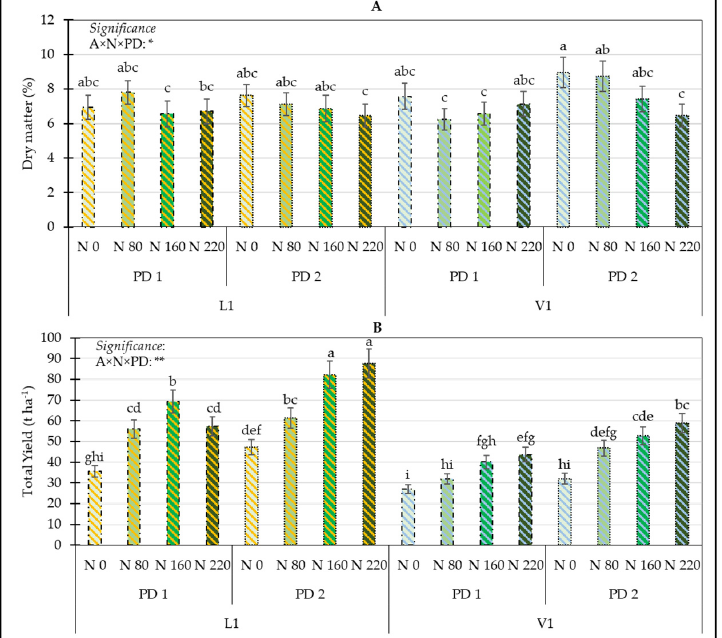
Figure 5. Influence of the interaction A × N × PD on dry matter ( A ) and total yield ( B ). Means with the same letter are not significantly different at p ≤ 0.05 according to Tukey’s test. Bars represent the standard error. ** = significant at p ≤ 0.01; * = significant at p ≤ 0.05; A = Accession; N = nitrogen; PD = Planting Date; L1 = Landrace (Bianca Calda di Comiso); V1 = Commercial Variety (Bianca di Mag- gio); N 0 = No-Nitrogen Fertilization; N 80 = fertilization with 80 kg N ha − 1 ; N 160 = fertilization with 160 kg N ha − 1 ; N 220 = fertilization with 220 kg N ha − 1 ; PD 1 = Early Planting Date; PD 2 = Traditional Planting